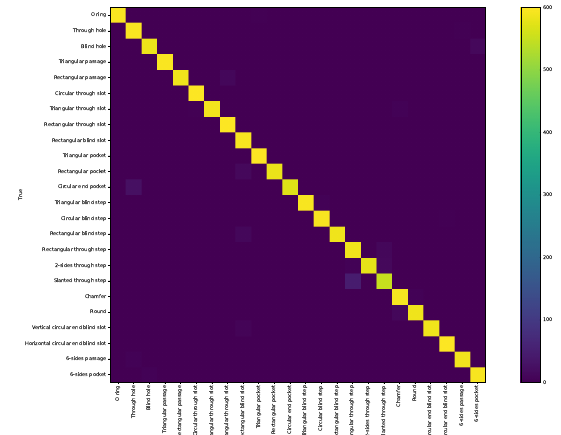
Figure A4. Confusion matrix for